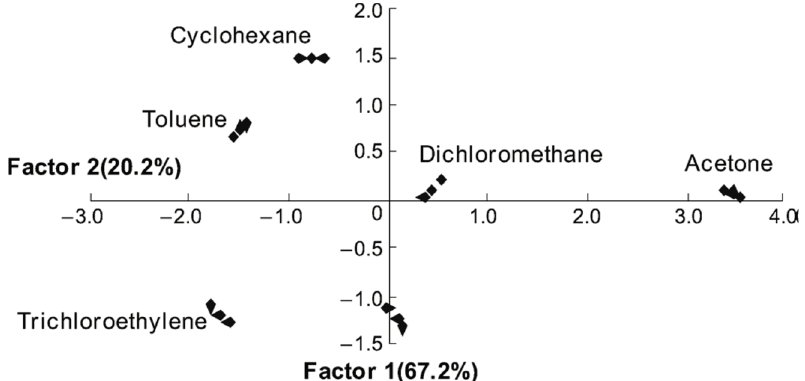
Figure 11. PCA-score plots obtained with the PSi/IL sensor arrays responding to six